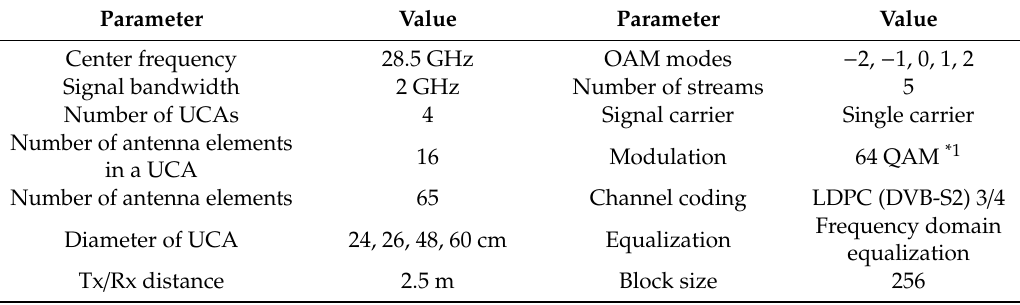
Table 2. Experimental parameters (OAM